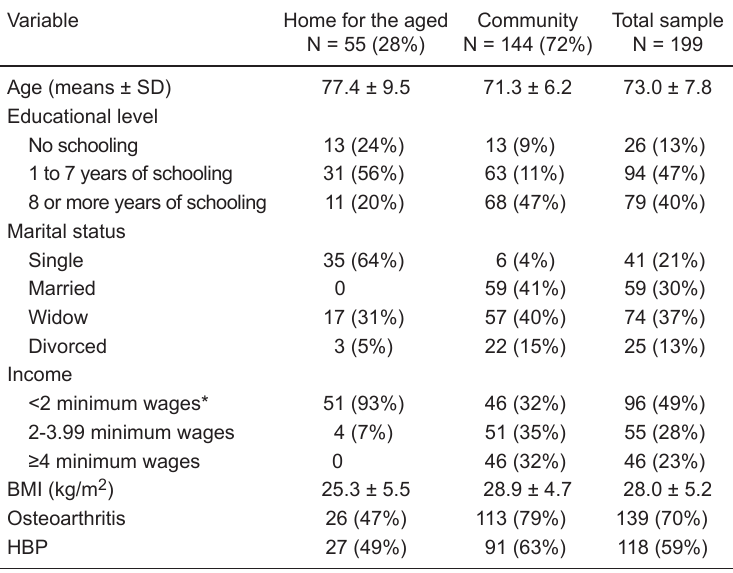
Table 1. Sociodemographic and clinical characteristics of the elderly women as- sessed.